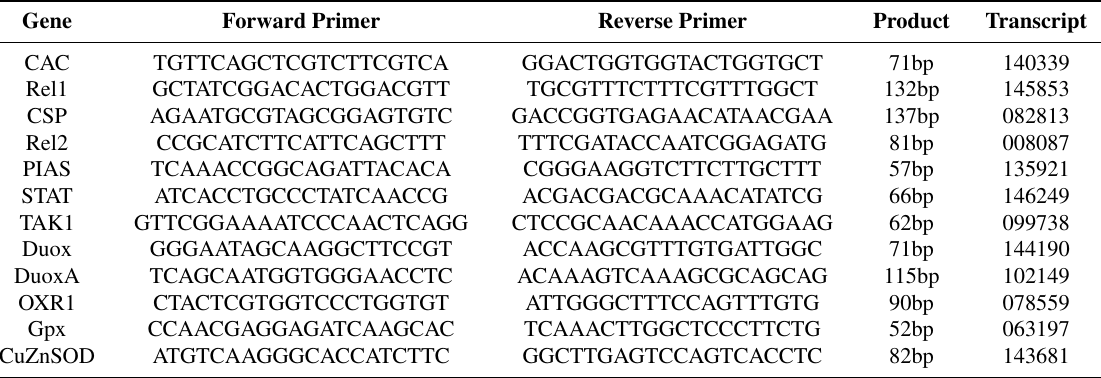
Oligonucleotide primers for qRT-PCR of immune pathway and ROS-related genes in